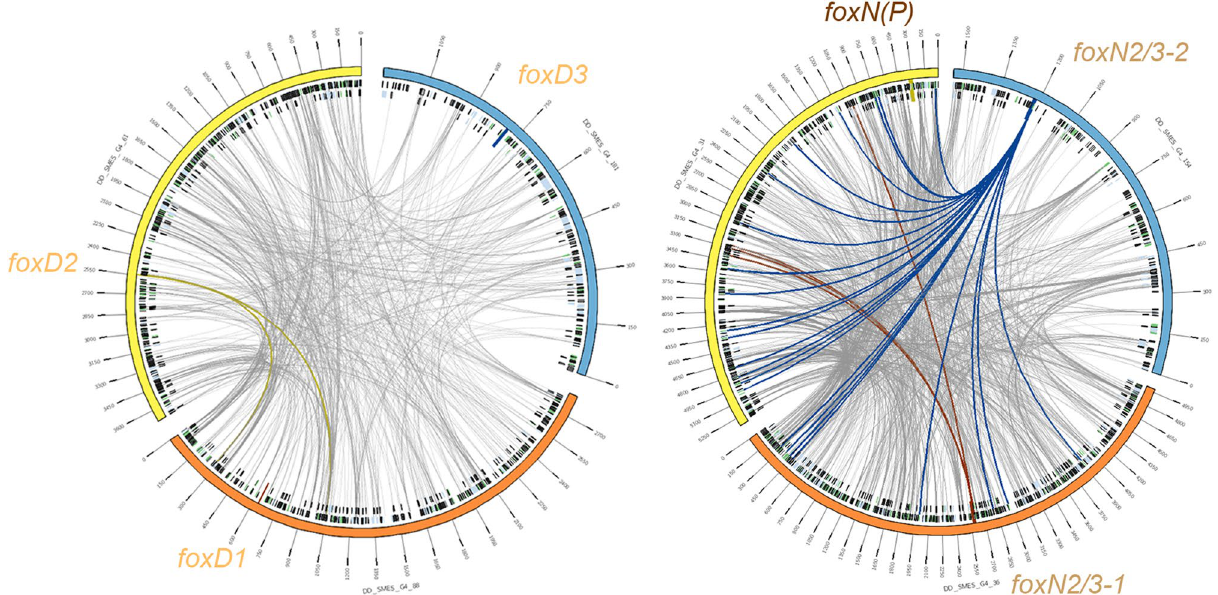
Figure 6. Fox paralogs do not present syntenic relationships in Smed genome. Alignments between scaffolds containing same-family Fox genes are represented with Circos. The Circos representation is composed of two tracks: In the outer ring the scaffolds containing Fox genes are labelled with their name (each tick representing 150 kb); in the inner ring, the repeating elements 29 coloured in green (LINEs), blue (TLR) and black (simple repeats and other). Repeats are filtered to be shown only when greater than 1 kb. Grey lines connecting the scaffolds are the representation of the alignments, filtered to be shown only when greater than 1 Kb. In each scaffold, the region corresponding to the Fox gene (+ -5 Kb) is represented as a perpendicular darker region, and all the links that fall onto it are coloured